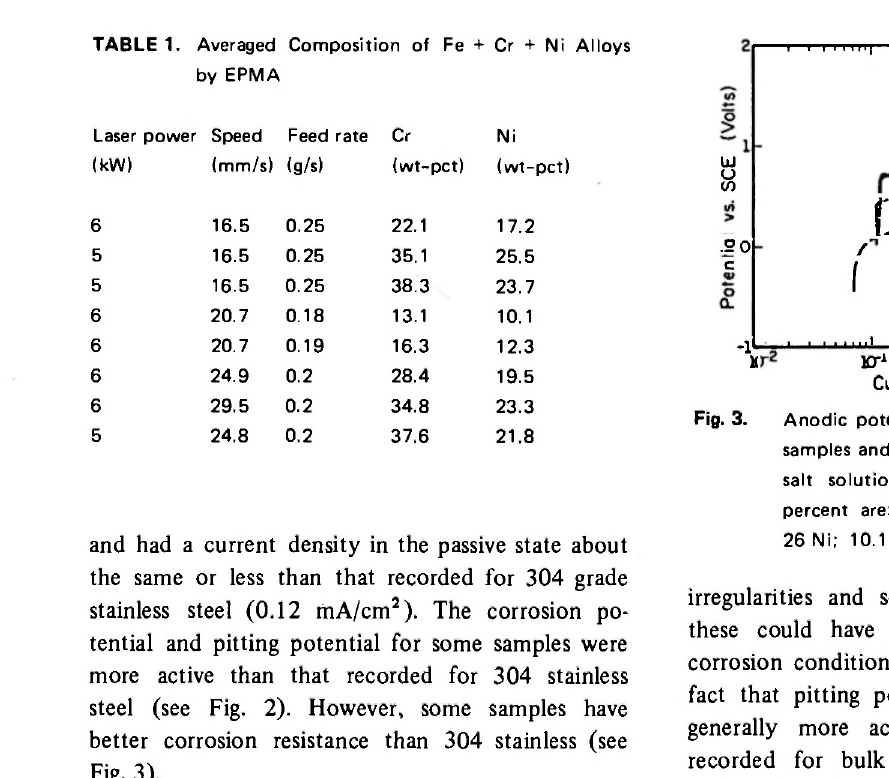
TABLE 1. Averaged Composition of Fe + Cr + Ni Alloys by ΕΡΜΑ Laser power Speed